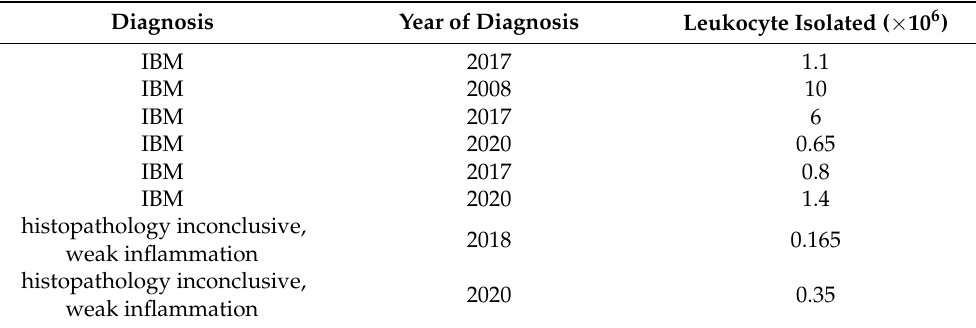
Figure 2. Violin representation of the number of leukocytes isolated from eight muscle biopsies processed independently. Dots show individual values, bold dotted-line the median and the lower and upper fine dotted-lines the 25th and 75th percentiles, respectively. Table 1. Condition and year of diagnosis of the patients who donated a muscle biopsy for this study. The numbers of leukocytes isolated using this protocol are indicated.